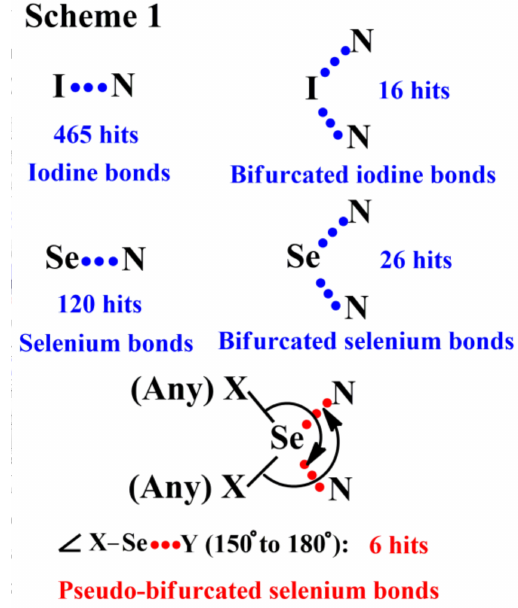
Scheme 1. A CSD search of the noncovalent bonds